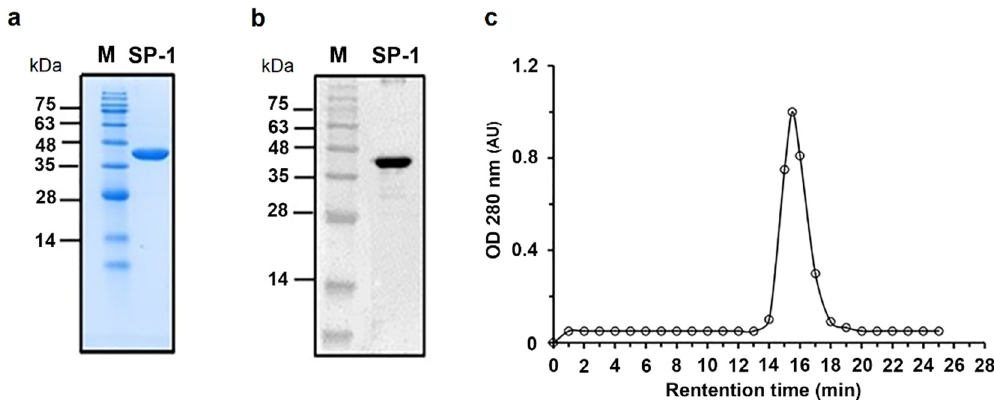
Figure 2. Purification and western blotting of recombinant SP-1. ( a ) Coomassie blue staining of an SDS-PAGE gel. SP-1 is represented by one single band with a molecular mass of 42 kDa. Lane M protein marker (molecular mass in kilodaltons). ( b ) Western blot analysis of purified SP-1 with anti-His tag antibody. ( c ) Size exclusion chromatography analysis of purified SP-1 (retention time, RT, 15 min) using protein markers of 669 kDa (RT, 8.9 min), 440 kDa (RT, 11.3 min), 158 kDa (RT, 13.2 min), 75 kDa (RT, 14.1 min), 44 kDa (RT, 15.3 min) and 29 kDa (RT, 16.9 min). Table 3. Steady-state kinetic parameters.